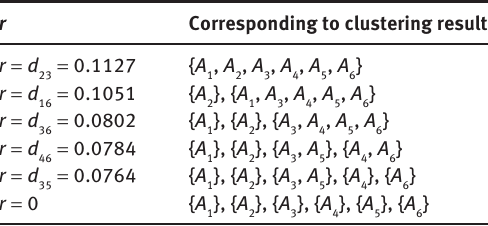
Table 2. SVNMST Clustering Results of the Six Operational Plans. r Corresponding to clustering